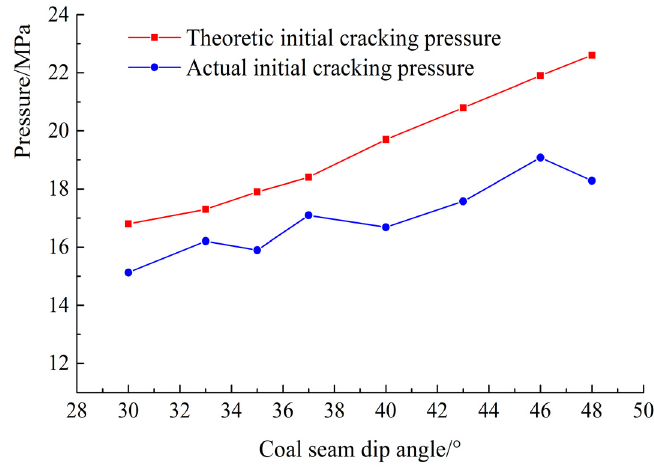
Figure 17. Comparison between the theoretic initial cracking pressure and the actual initial cracking